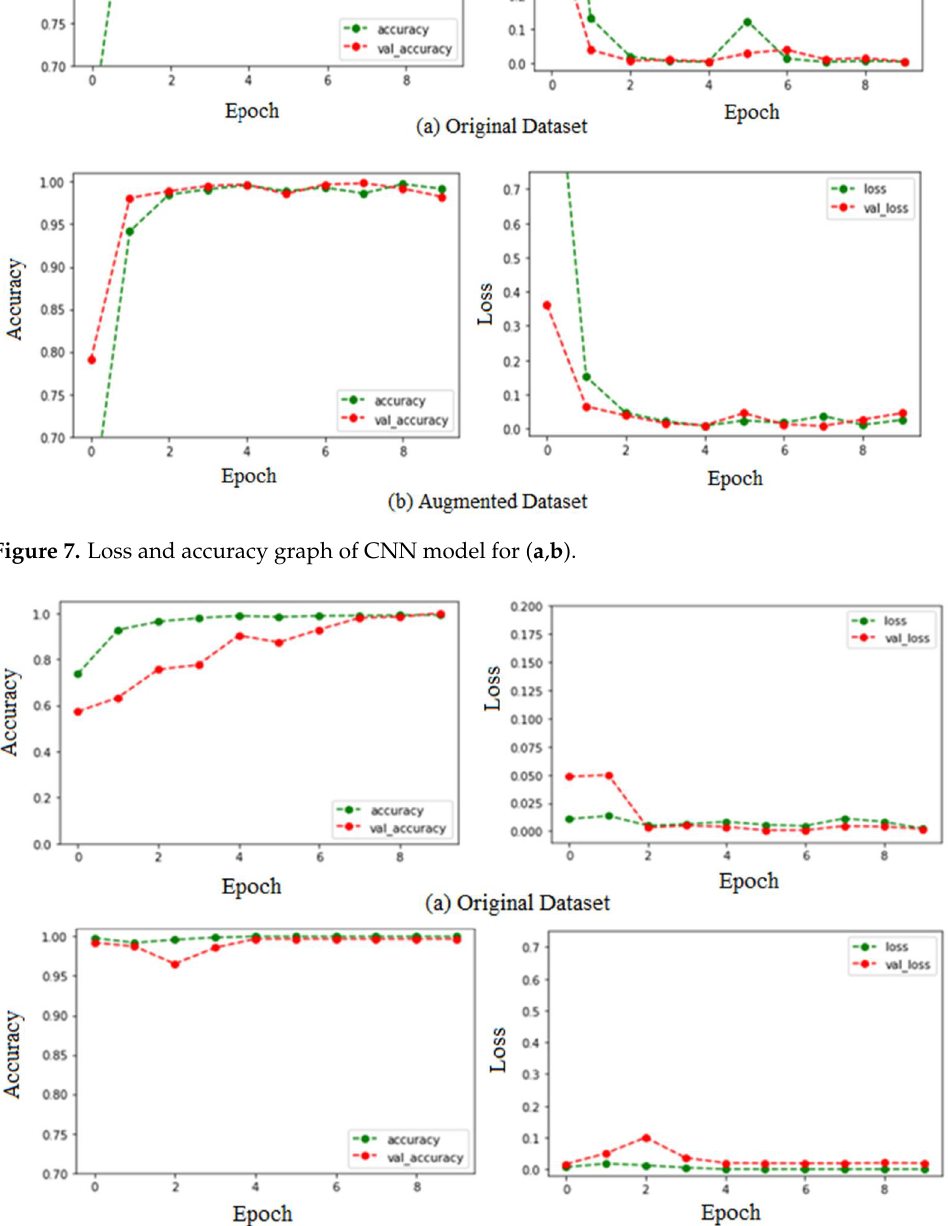
Figure 9. The proposed model results for ( a ) unripe, ( b ) ripe, and ( c ) over-ripe. Table 4 describes the training accuracy and validation accuracy for the three datasets for the proposed CNN model and AlexNet model. The images in the test dataset are shown in Figure 9, (a) the 3rd image is classified as unripe, (b) the 56th image is classified as ripe, and (c) the 89th image is classified as over-ripe when tested. We used bar graphs to plot 0 to unripe, 1 to ripe, and 2 to over-ripe. In Figure 9, we plotted the image and predicted values bar graph of that image. Table 4. Training and validation accuracy for CNN and AlexNet model. Datasets